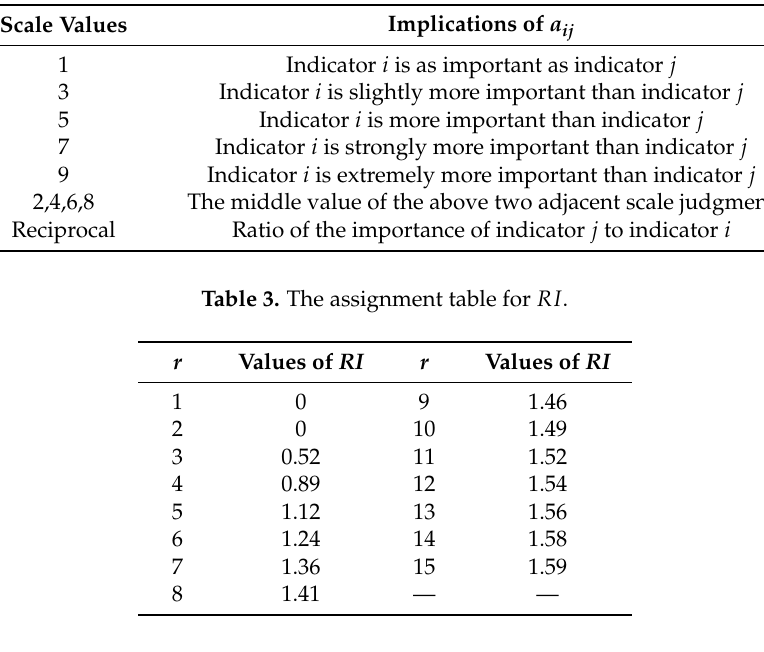
Table 2. The 1–9 degree scale implications of analytic hierarchy process (AHP).